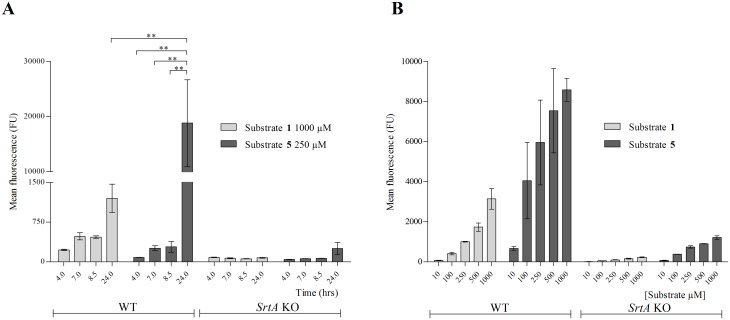
Kinetics determination of substrate 5.8325–4 WT and srtA KO strains were incubated in the presence of (A) either 1 mM of substrate 1 or 250 μM of substrate 5 until either exponential (4 hrs), post-logarithmic (7 hrs), late exponential (8.5 hrs) or late stationary phase (24 hrs) in LB medium. The mean fluorescence of substrate 1 and substrate 5 is depicted on y-axis. (B) Washed and diluted (OD600nm 0.5) late stationary grown WT and srtA KO bacteria were incubated with either 10 μM, 100 μM, 250 μM, 500 μM or 1 mM substrate 1 or substrate 5 in SrtA buffer during 17 hrs. The mean fluorescence was determined by FACS. The signal obtained with substrate 1 at 1 mM after 24 hrs of incubation was significantly lower than the signal obtained with substrate 5 at 250 μM after 24 hrs (P < 0.001). Substrate 5 signals at time points 4 hrs, 7 hrs and 8 hrs were all significantly lower in comparison to the signal obtained with the same substrate at 24 hrs time point at 250 μM (P < 0.001).